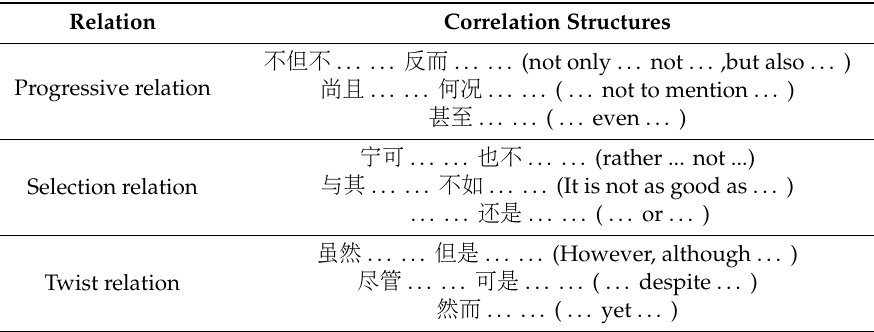
Table 1. Part of relations and correlation